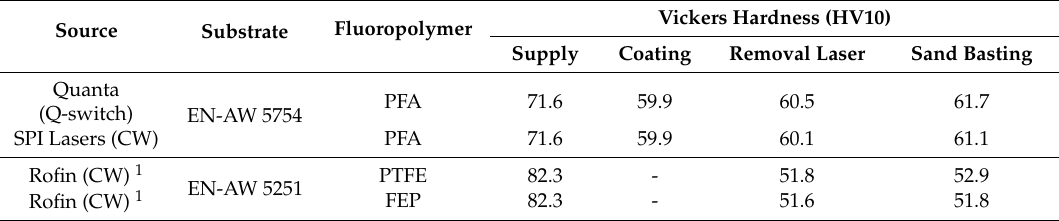
Table 9. Vickers hardness values (HV10) for PFA-coated EN AW 5754 substrates and PTFE- and FEP-coated EN AW 5251 substrates, in di ff erent